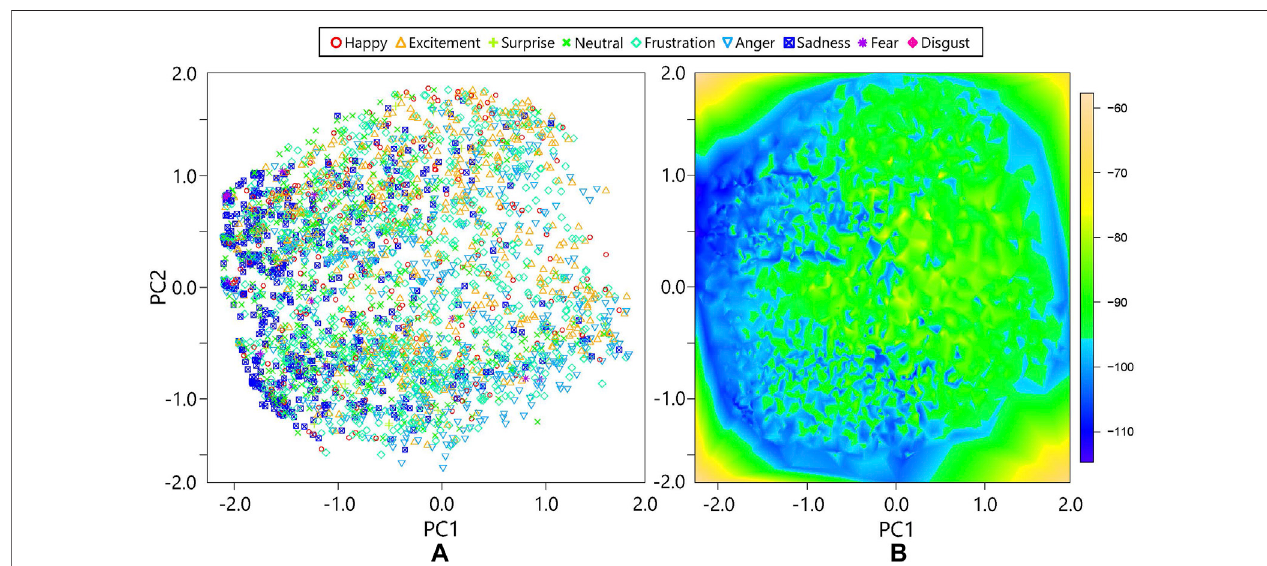
FIGURE5| Representationsandenergiesinthe fi rstandsecondPCspaces: (A) activationsofthethirdhiddenlayeroftheMDBNwithemotionallabels; (B) energy distribution of hidden